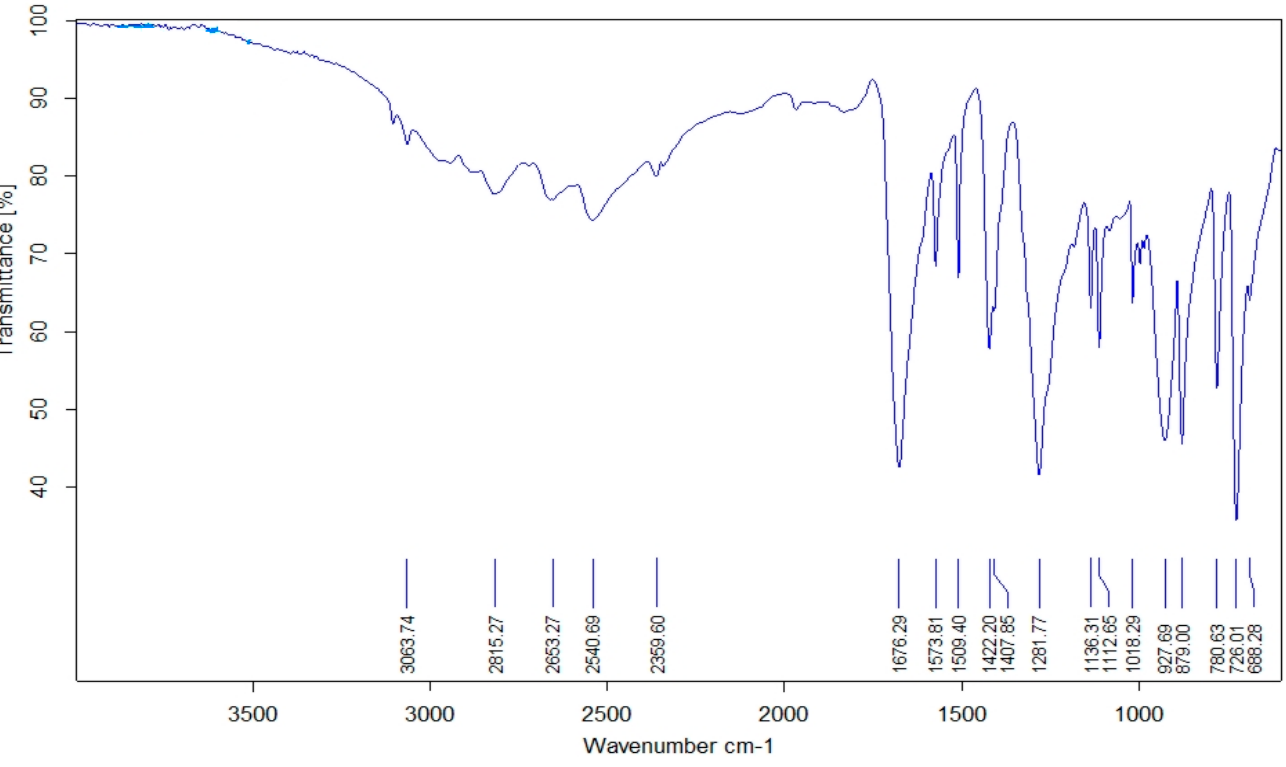
Figure 2. The FT-IR spectrum of PMG Figure 2. The FT ‐ IR spectrum of PMG nanoparticles .